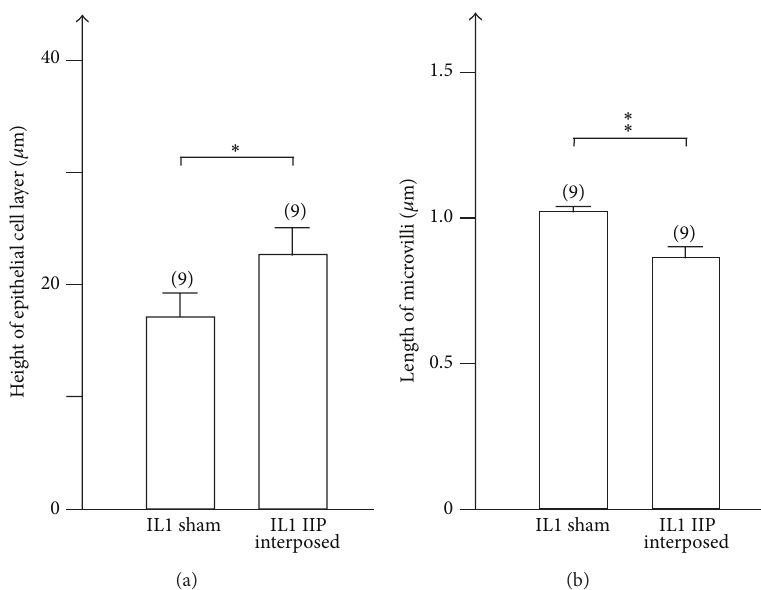
Figure 9: Effect of ileal interposition on height of the epithelial cell layer (a) and length of microvilli (b). Electron microscopic images from ileal epithelial cells of sham-operated animals and of interposed ileum similar to those shown in Figures 8(d) and 8(e) were employed to measure length of microvilli. The measurements were performed on 3 animals using three sections from different regions of each analyzed segment. For measurement of epithelial height (a) 11–13 individual measurements were performed on each section. Length of microvilli in a section was determined in 3 cells measuring 5 microvilli per cell. Mean values ± SEM. The number of analyzed sections is indicated in parenthesis. ∗ 𝑝 < 0.05 , ∗∗ 𝑝 < 0.01